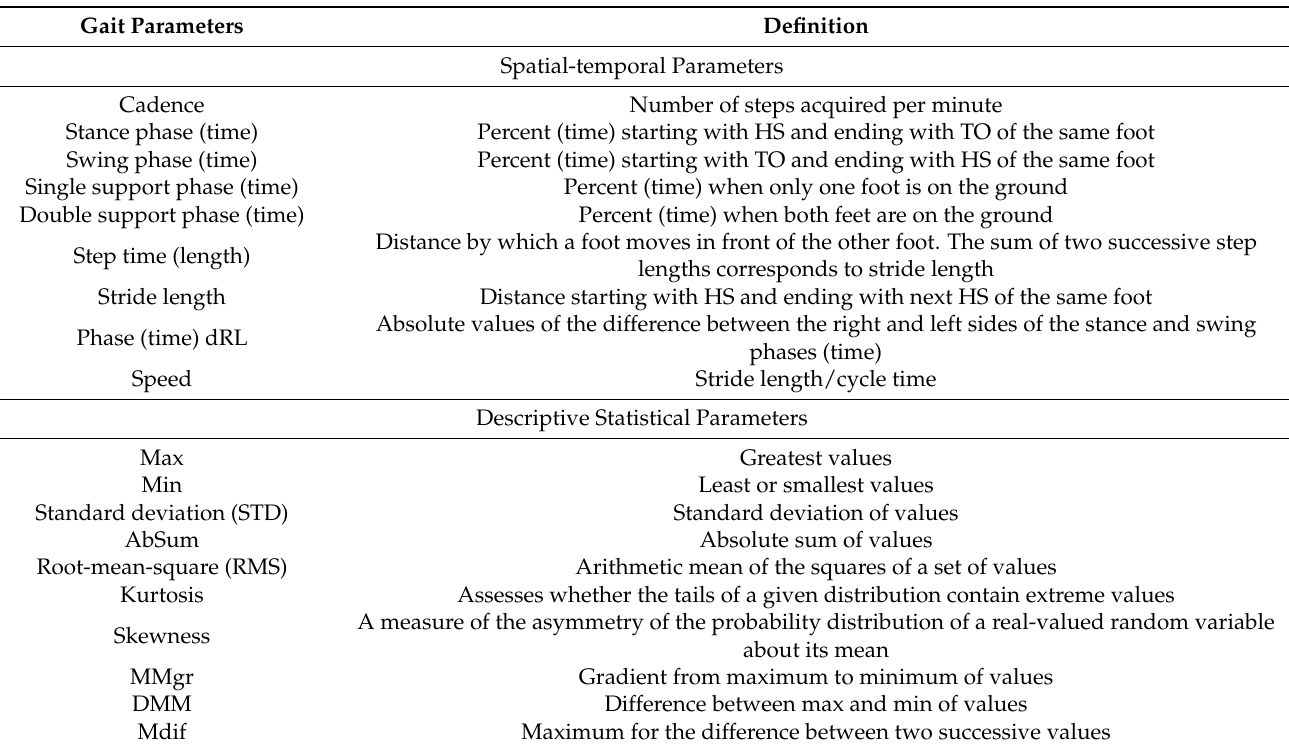
Table 4. Definition of gait